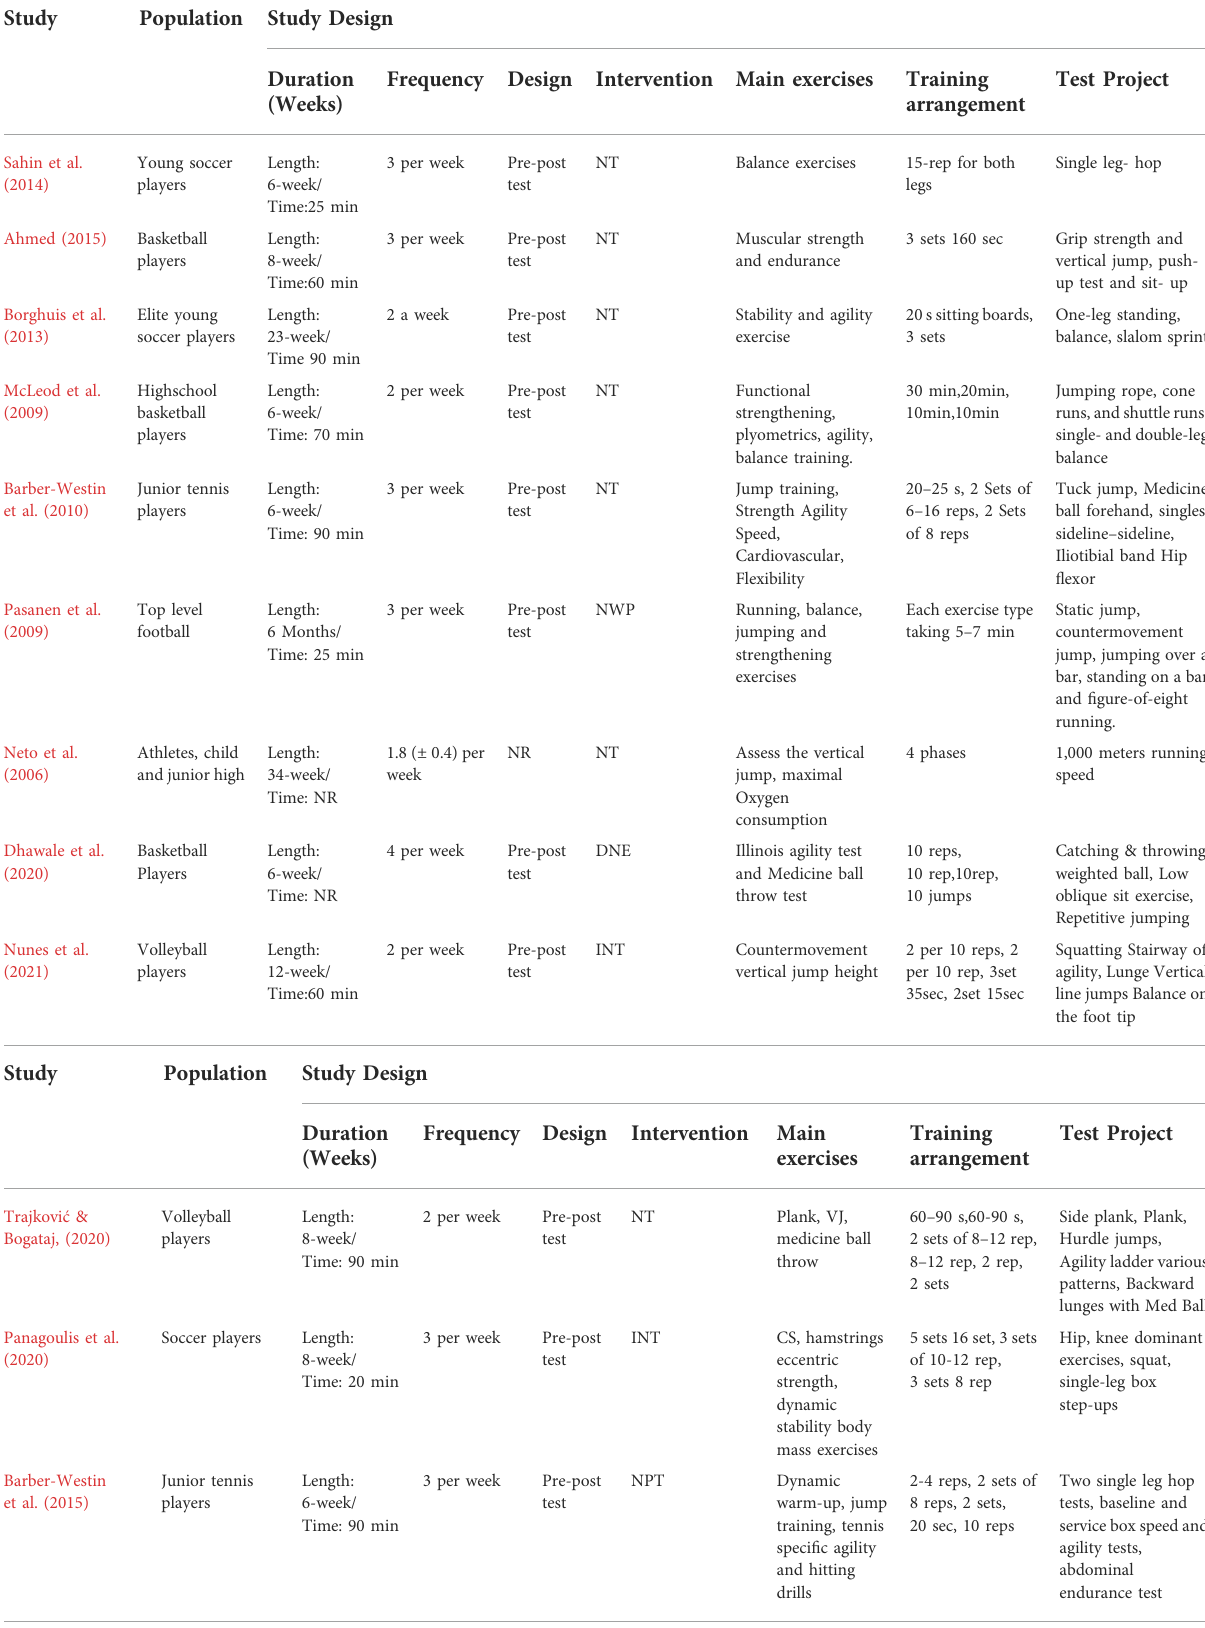
TABLE 2 Population, Study design, interventions, and test